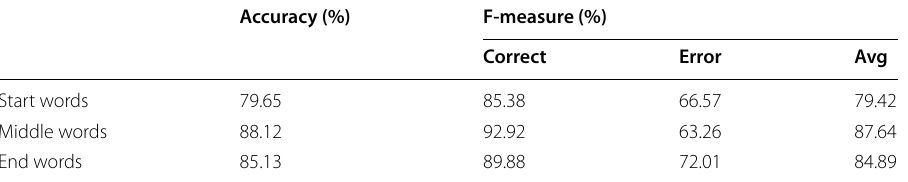
Table 8 Word position analysis on the test